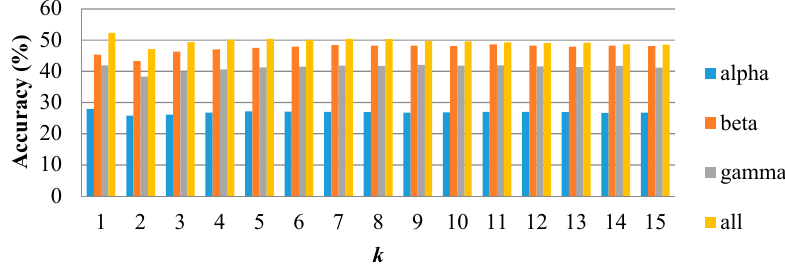
Figure 9. Average classification performance of bispectrum features by varying k values for the RBD group using KNN.